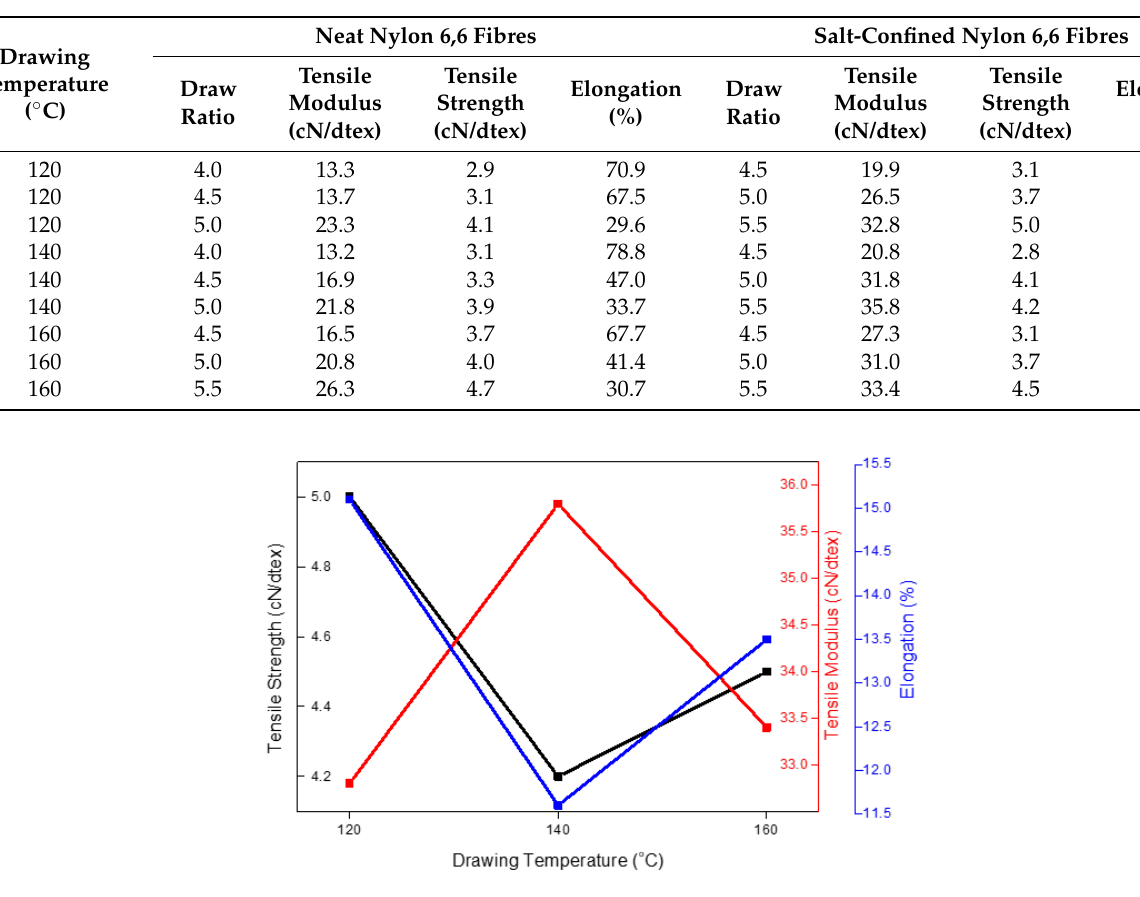
Figure 12. Mechanical properties of the drawn 3% salt-confined nylon 6,6 fibres at a drawing ratio of 5.5 and drawing temperature of 120, 140 and 160 ° C. Table 3. Mechanical Properties of the Neat and Salt-confined Nylon 6,6 Fibres.